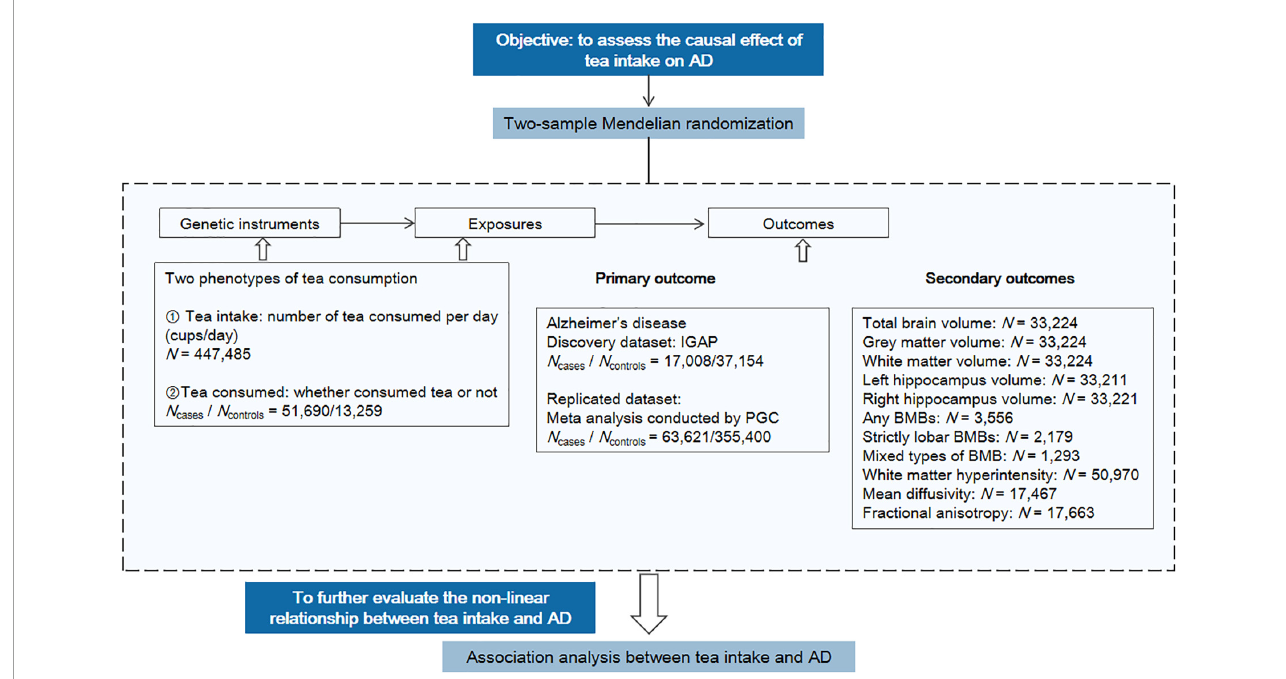
FIGURE2 Overview of the study design. The workflow summarized the information of datasets, exposures, and outcomes we used in the primary and secondary MR analyses. AD, Alzheimer’s disease; PGC, Psychiatric Genomics Consortium; BMB, brain microbleed.